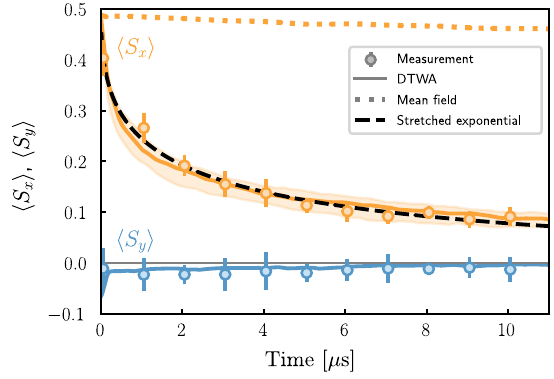
FIG. 4. Many-body relaxation dynamics of a Heisenberg XXZ Rydberg spin system. The dots show the temporal evolution of the two magnetization components h S and h S from a tomo- x i y i graphic spin readout. Error bars are determined from 120 realizations of the experiment at a peak spin density of ρ 0 ¼ S 1 . 2 ð 3 Þ × 10 9 cm − 3 . The observed dynamics are clearly incon- sistent with the mean-field prediction including imperfect initial state preparation (dotted line). The solid lines are DTWA predictions without free parameters. The shaded area indicates the systematic uncertainty of the measured density. The dashed line depicts a fit of the data with a stretched exponential function yielding a stretching exponent of β ¼ 0 . 32 ð 2 Þ